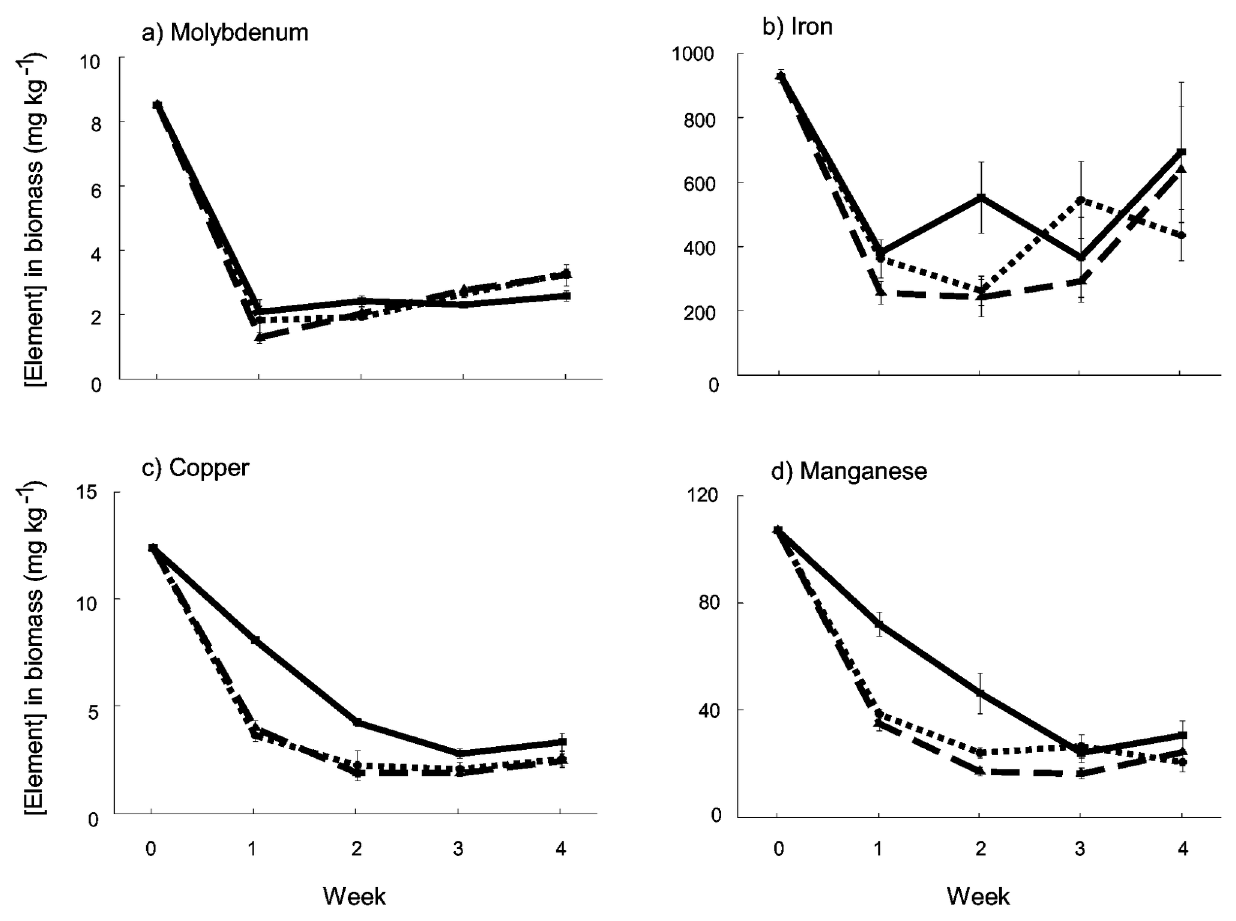
Figure 4. Concentrations of essential trace elements in Oedogonium sp. biomass cultured in Ash Dam Water at three levels of carbon addition. Unbroken, dashed and dotted lines show data for the 0, 3 and 6 L min -1 CO doi: